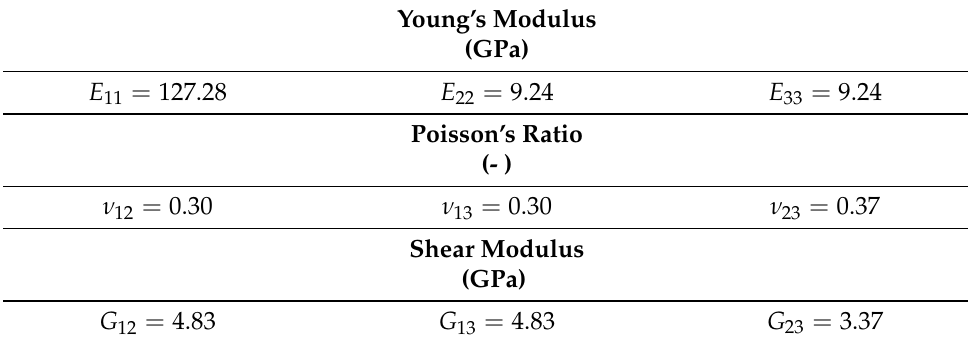
Table 2. Mechanical properties of CFRP.